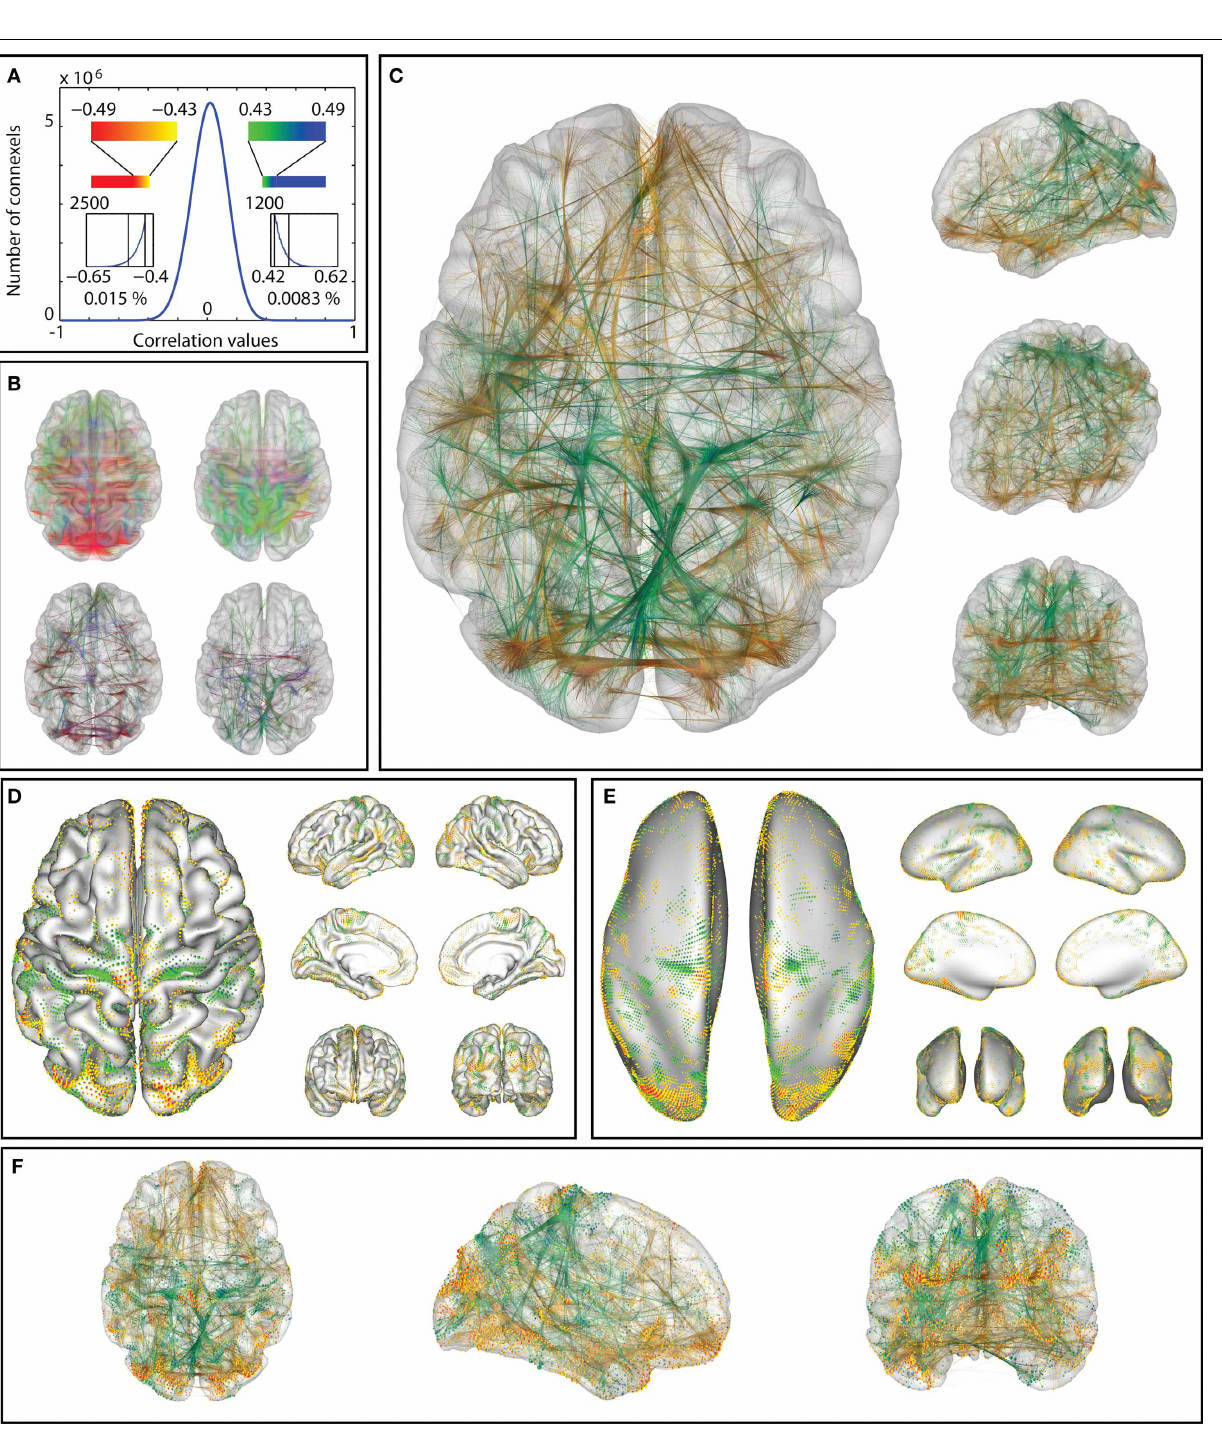
bottom, C ) clarifies the structure of the connectivity graph. The same correlations visualized with surface connectivity glyphs (D,E) , which clarify the anatomical placement of the connections termination points on the pial (D) and inflated (E) surface representation. Combined visualization with glyphs and bundlings (F) . In (C–F) , positive and negative values are shown in the same visualization (yellow-to-red color scale for negative, green-to-blue color scale for positive correlation with